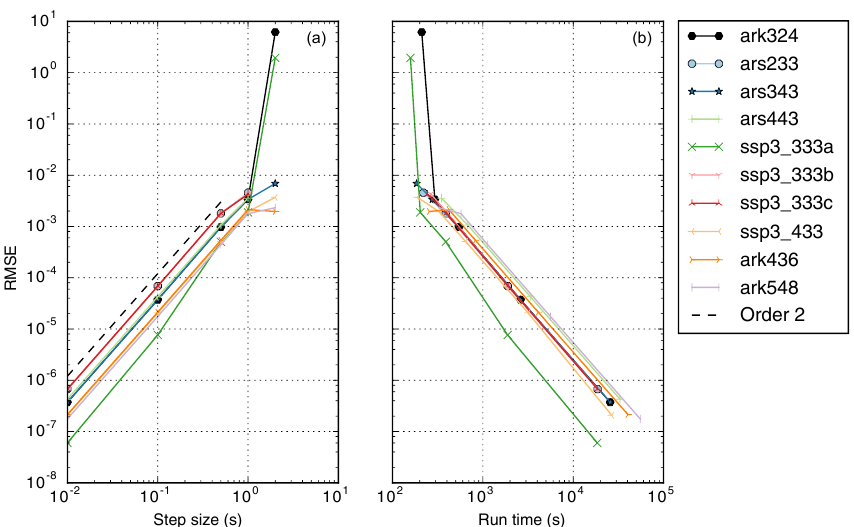
Figure 4. Accuracy (a) and efficiency (b) for the third-, fourth-, and fifth-order methods using the Rosenbrock-like approach with the IMEX- A splitting. The dashed line represents second-order convergence. Results using multiple Newton iterations to compute the stage solutions give nearly identical error values to the Rosenbrock-like results but increase the computational cost by at least 10%.